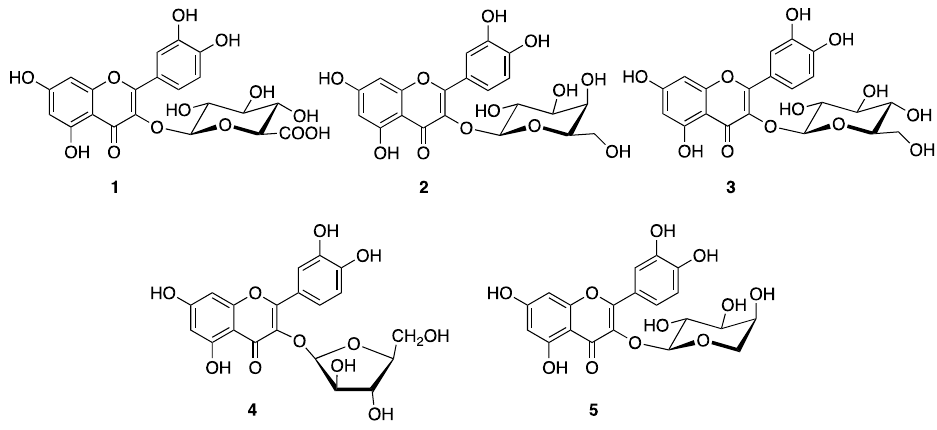
Figure 2. Chemical structures of flavonol quercetin derivatives 1 ‒ 5 . Fibril formation is reported relative to wt-TTR homotetramer, where the amount of aggregation in the absence of a stabilizer is assigned to be 100%. Therefore, 5% fibril formation (FF) in the presence of the reference drug diflunisal corresponds to 95% inhibition, Figure 3. QUE glycoside derivatives showed moderate activity as a stabilizer of FF. The percentage of fibril formation (%FF) of wt-TTR in the presence of QUE 3- O - α - L -arabinofuranoside ( 5 ) is 57%, suggesting that derivative (5) has poor interaction with TTR binding sites. However, the %FF decreases from 45%, for QUE 3- O - β - D - glucuronopyranoside ( 1 ) and QUE 3- O - β - D -glucopyranoside ( 3 ), to 40% for QUE 3- O - β - D -galactopyranoside ( 2 ) and QUE 3- O - α - L -arabinopyranoside ( 4 ) (Figure 2).